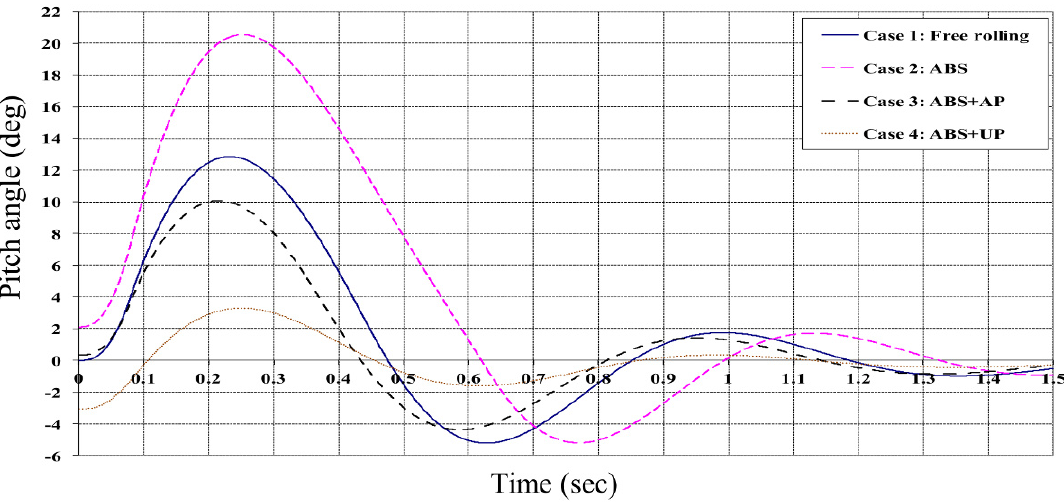
Figure 15. Pitch angle of the vehicle body for all cases at full frontal collision and speed of 70